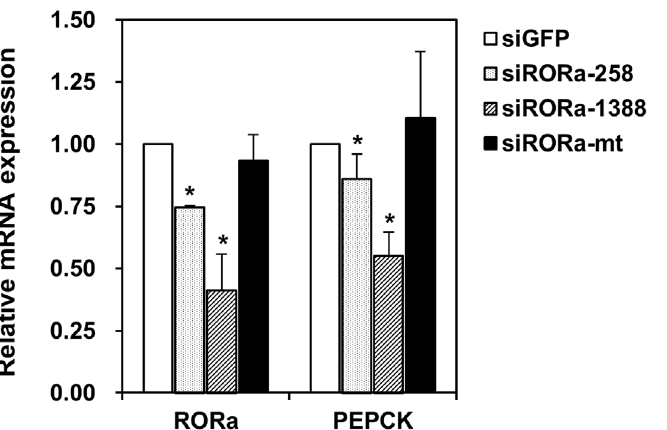
Fig 5. Effect of ROR α deficiency on PEPCK expression. Suppression of endogenous ROR α by siRNA significantly decreased PEPCK mRNA in HepG2 cells. HepG2 cells were transfected with 50 nM siRNA, and analyzed by qRT-PCR to measure expression of ROR α and PEPCK. siRNAs that target sequences around 258 bp (siRORa-258, dotted bars) and 1388 bp (siRORa-1388, hatched bars) downstream of the ROR α start codon decreased ROR α and PEPCK mRNA levels, while a scrambled siRNA (siRORa-mt, closed bars) did not. siRNA against green fluorescent protein was used as negative control (siGFP, open bars). Data are mean ± S.E. of three experiments, and are normalized to 18S rRNA. * , p < 0.05.